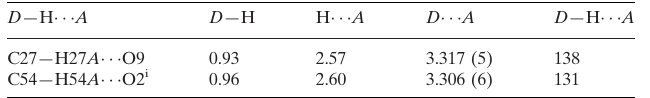
Hydrogen-bond geometry (A˚ , (cid:2)